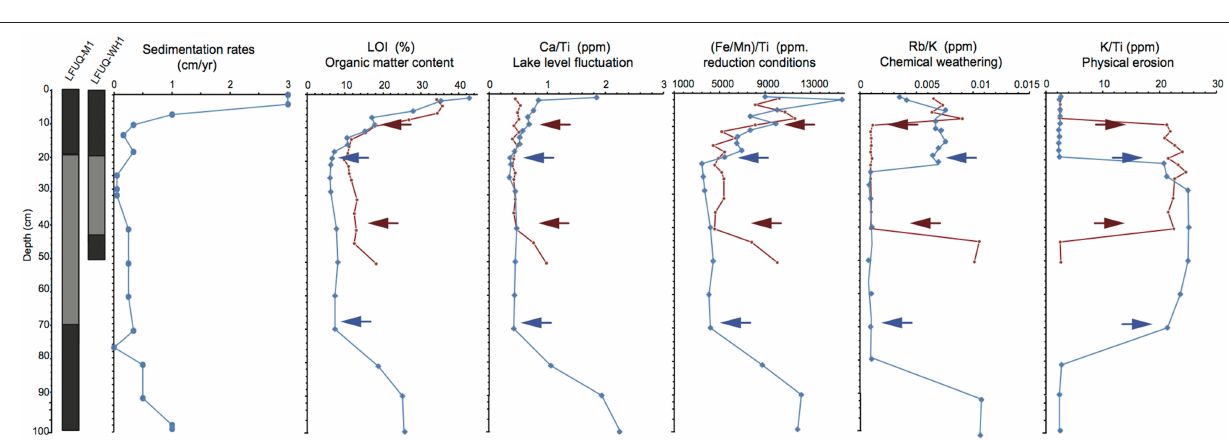
FIGURE 4 | Lithostratigraphy (dark gray, organic rich sediments; pale gray, low organic sediments), sedimentation rates, sedimentary profiles of organic matter content (LOI) and geochemical index ratios of Ca/Ti, (Fe/Mn)/Ti, (d) Rb/K, and K/Ti in the cores LFUQ-M1 (blue line) and LFUQ-WH1 (red line). Two key features in lithostratigraphy changes, LOI and geochemical index ratios observed across the cores LFUQ-M1 (blue arrows) and LFUQ-WH1 (red arrows) were used for core